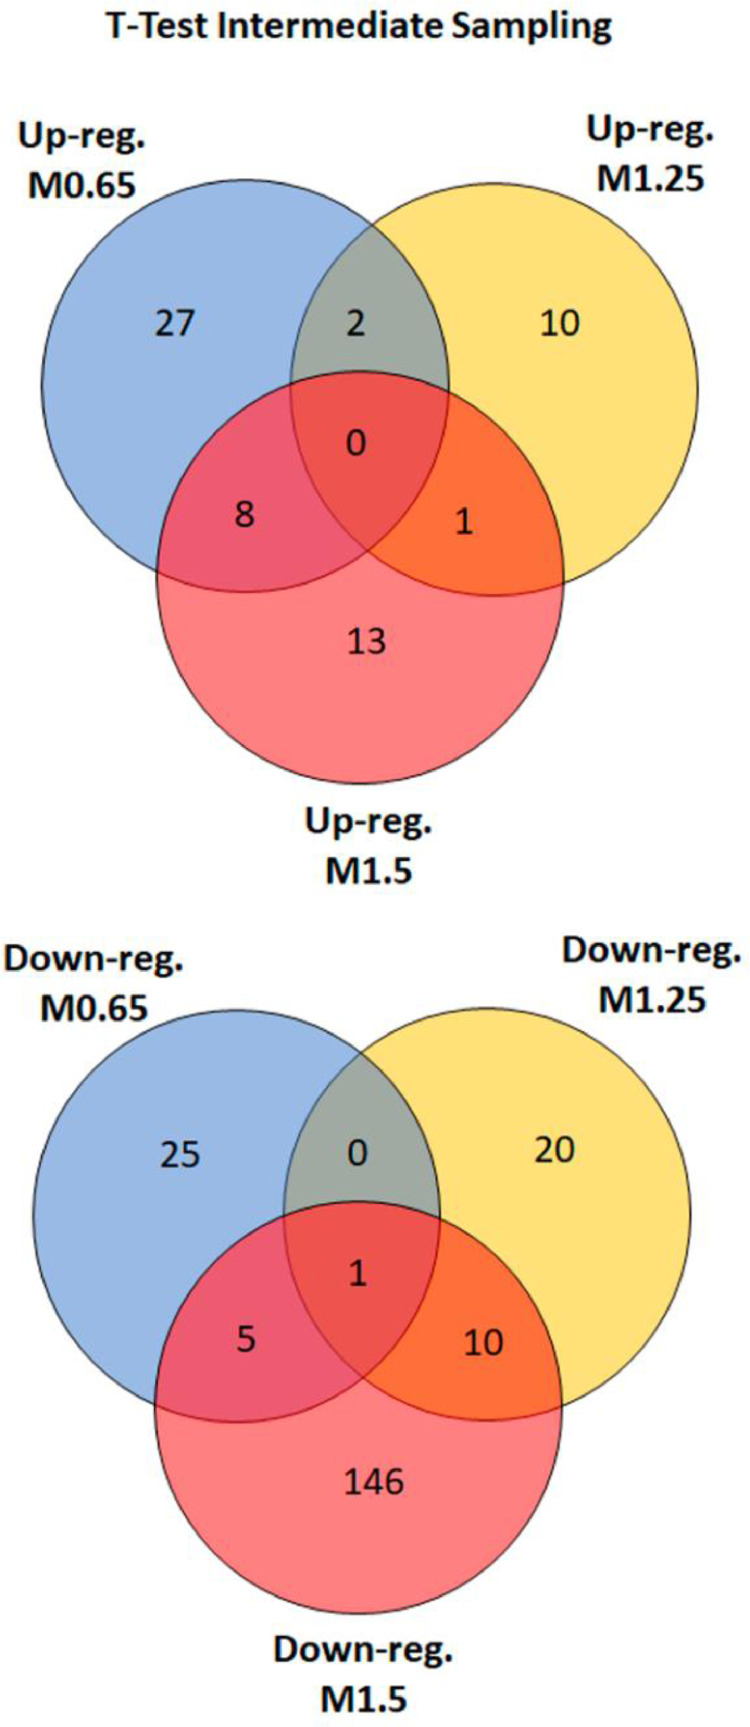
Analysis of DAP (Student's t-test, p < 0.05) between treatment versus reference diet i.e., at lower (0.77% Met-w/w) and higher (1.36% Met-w/w and 1.66% Met-w/w) concentrations in respect to the reference diet (1% Met-w/w). Venn diagrams depict the number of up-and down-regulated proteins between treatments at the 18-days experimental trial.